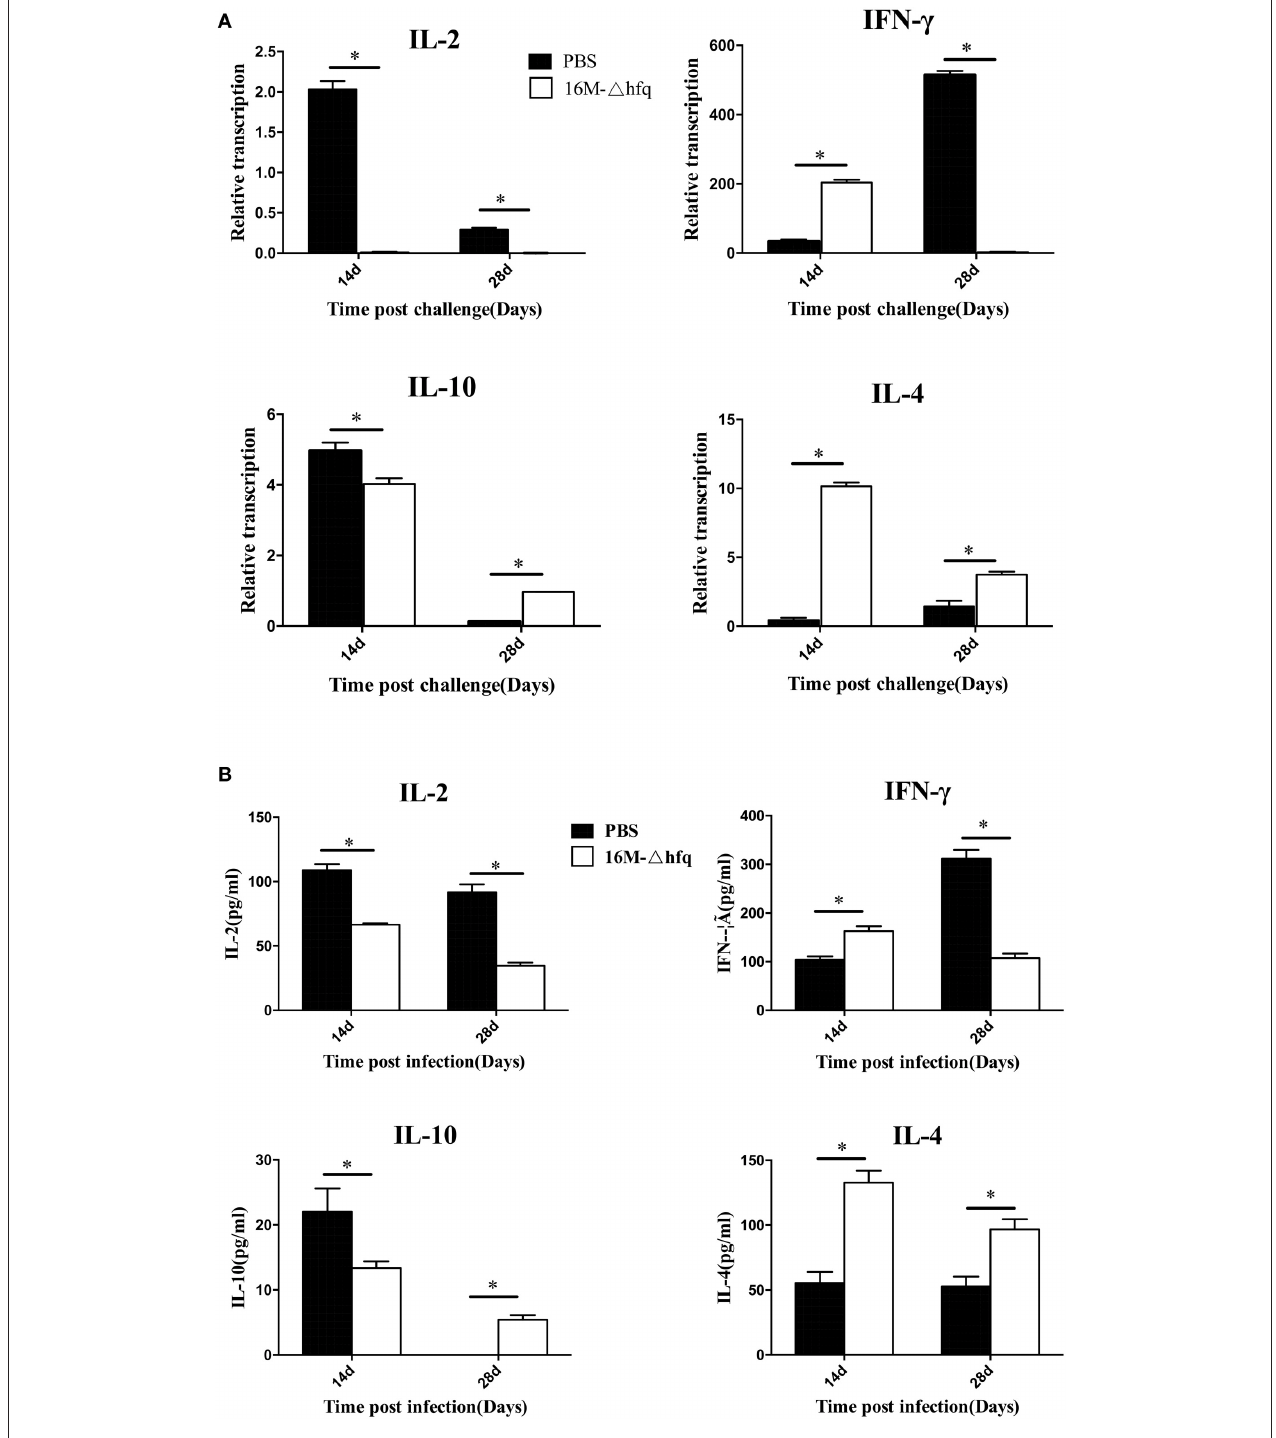
FIGURE 5 | Expression and secretion pattern of cytokine after the challenge. Spleens were isolated from challenged mice at 14 and 28 days post-infection, the relative transcription levels (A) and secretion level (B) of IL-2 , IFN- γ , IL-4, and IL-10 , and were determined. The transcription levels were compared to each cytokine expression level of PBS group at 7 days. Significant differences between the mutant and parent strain were indicated as follows: * P < 0.001 .